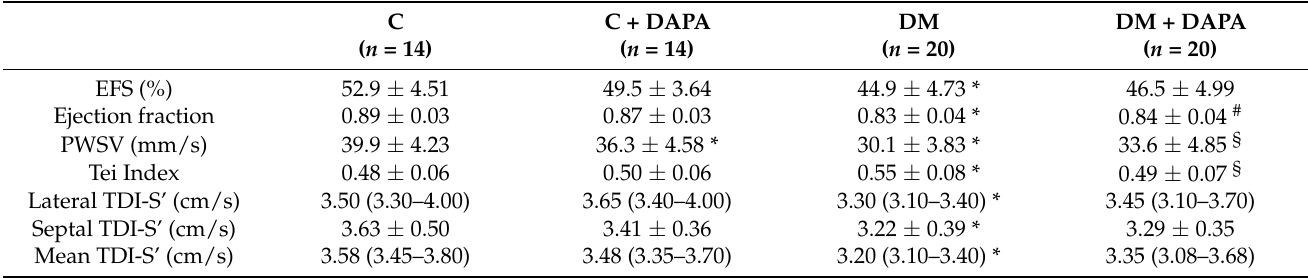
Table 3. Echocardiographic data for left ventricular systolic function.